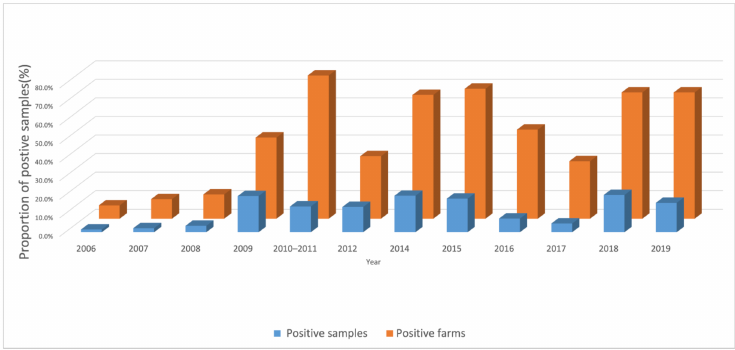
Figure 2. Proportion H5-positive farms and samples, from 2006 to 2019, by